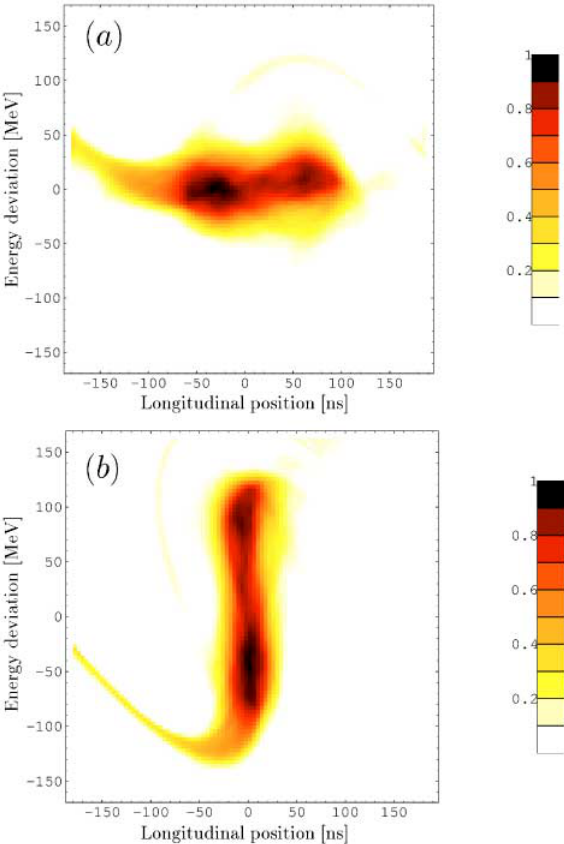
FIG. 5. (Color) Phase space reconstruction of the bunch. Part (a) shows the bunch with maximum length. In part (b), taken a quarter of a synchrotron period later, the bunch reached its minimum length.